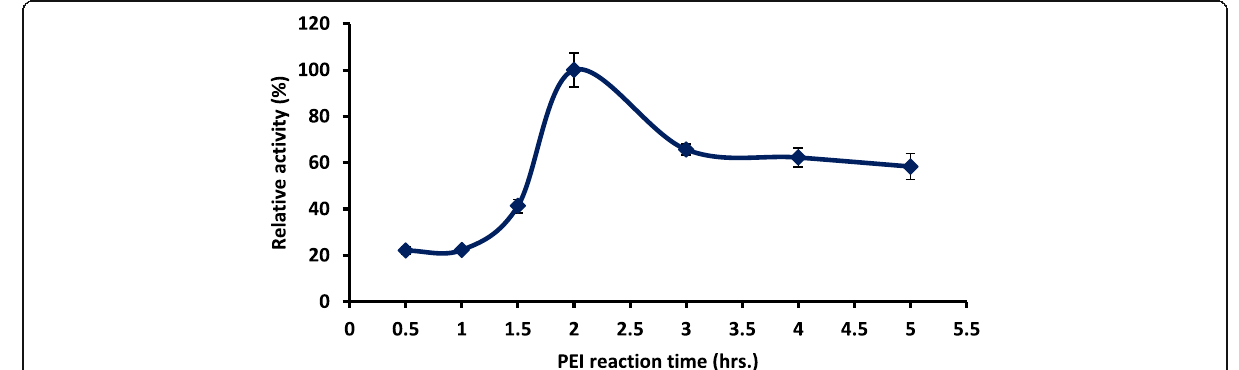
Fig. 4 Effect of variation of PEI reaction time on the catalytic activity of immobilized enzyme